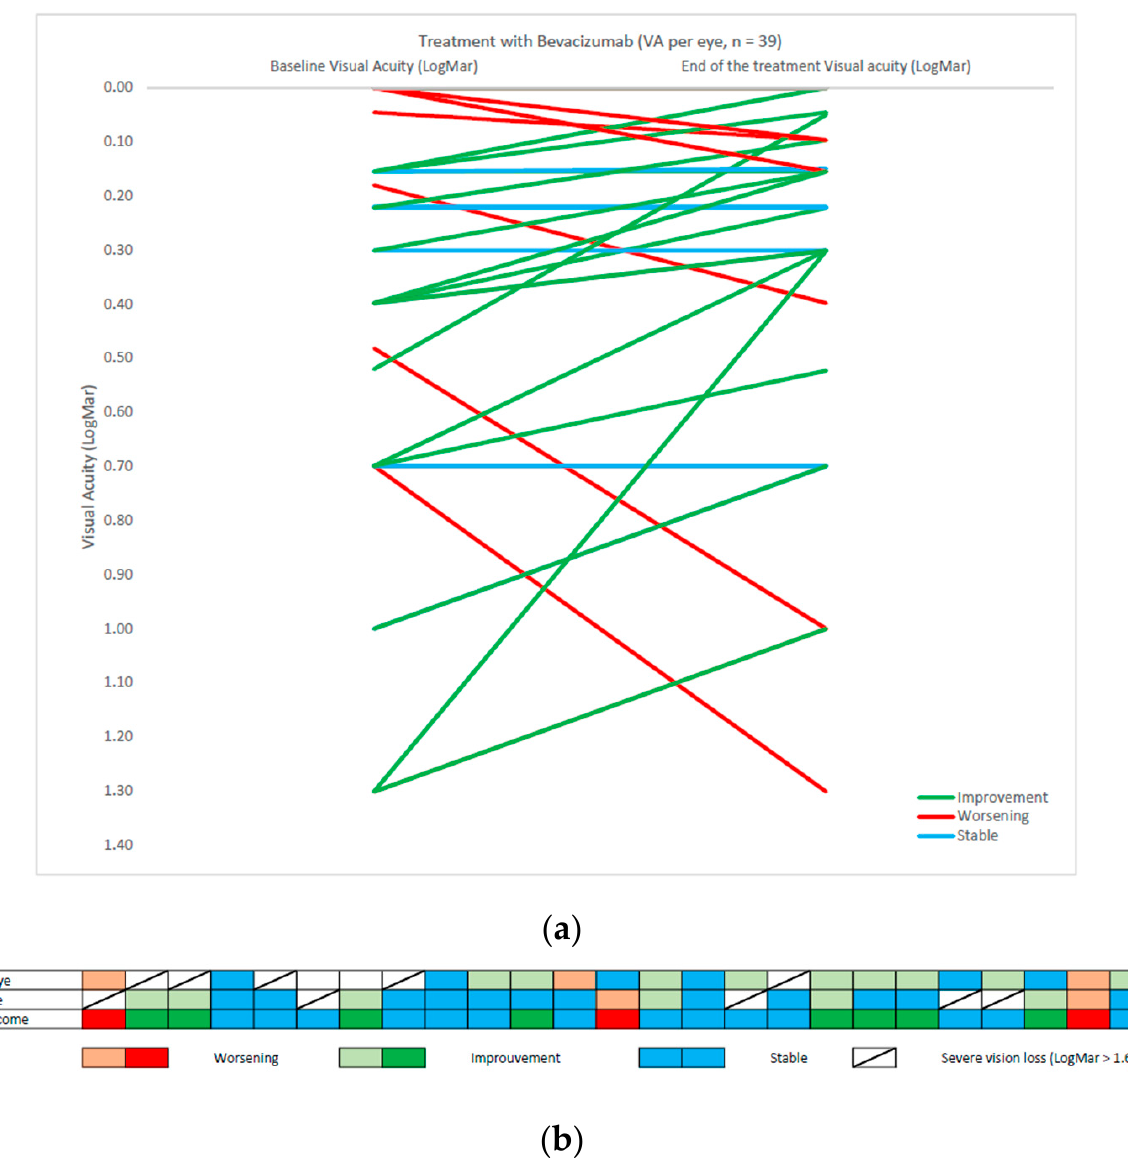
Figure 1. ( a ) VA graphical outcome per eye for 25 patients in baseline and after treatment with Bevacizumab: 39 evaluable eyes, monocular blindness excluded. ( b ) VA outcome represented with a column for each patient. Right and left eye evaluation and binocular outcome according to the graphical representation standardized by the SIOPE NF1 OPG workshop.